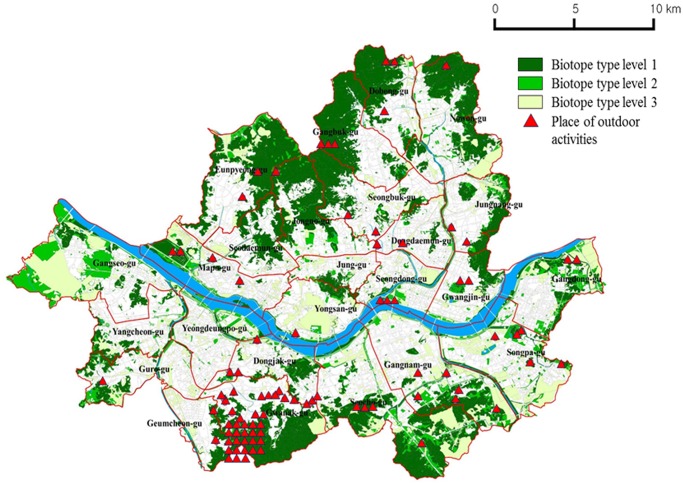
The spatial distribution of scrub typhus cases with the epidemiological linkage to outdoor activities in Seoul and biotope levels during 2010–2013.Infection mostly occurred in the biotope level-1 area, which is a suitable place for mite survival.